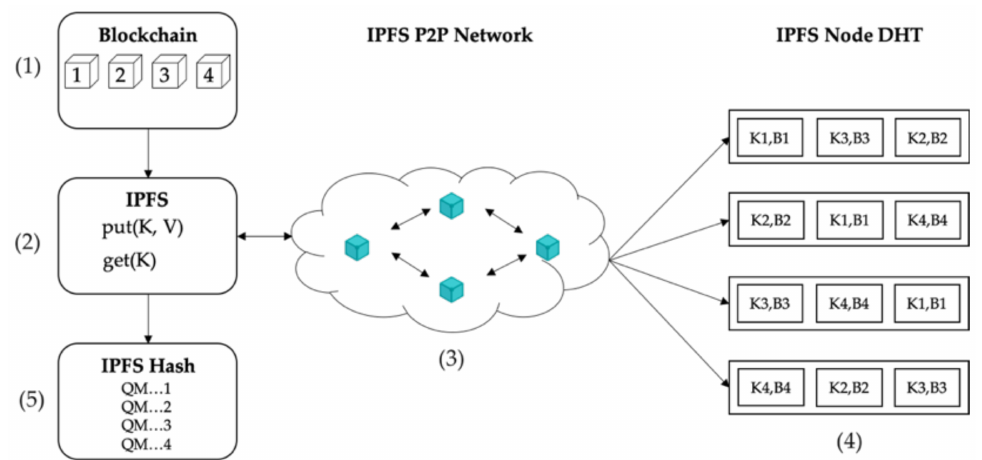
Figure 3. DHT block storage example.